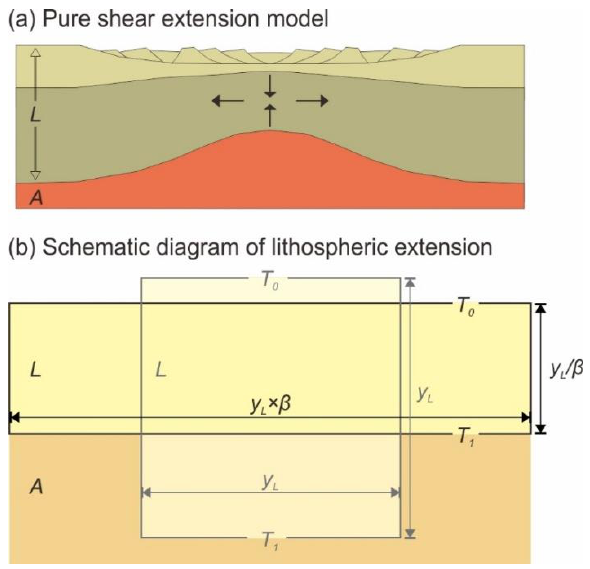
Figure 1. ( a ) A schematic model of the pure shear extension (after [10,14]). The lithosphere is composed of a brittle deformed upper layer and a ductile deformed lower layer. ( b ) A schematic diagram of the lithospheric extension (after [40]). The lithosphere (grey line) is extended to the thinned lithosphere (black line). 𝐿 : lithosphere, 𝐴 : asthenospheric mantle, 𝑦 𝐿 : initial thickness of lithosphere, 𝛽 : stretching factor, 𝑇 0 : temperature of lithosphere top, 𝑇 1 : temperature of asthenospheric mantle.